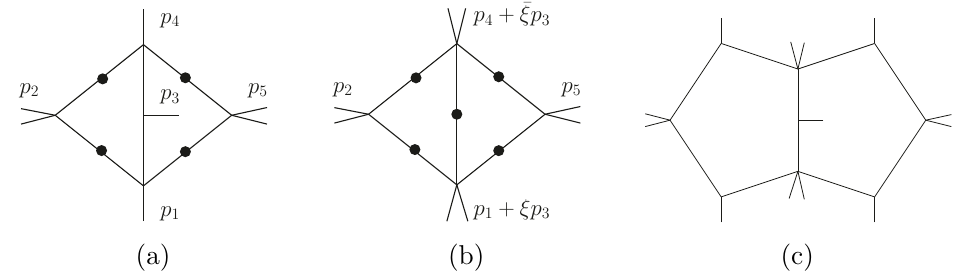
Figure 5 . Finite six-dimensional integrals. Dots denote doubled